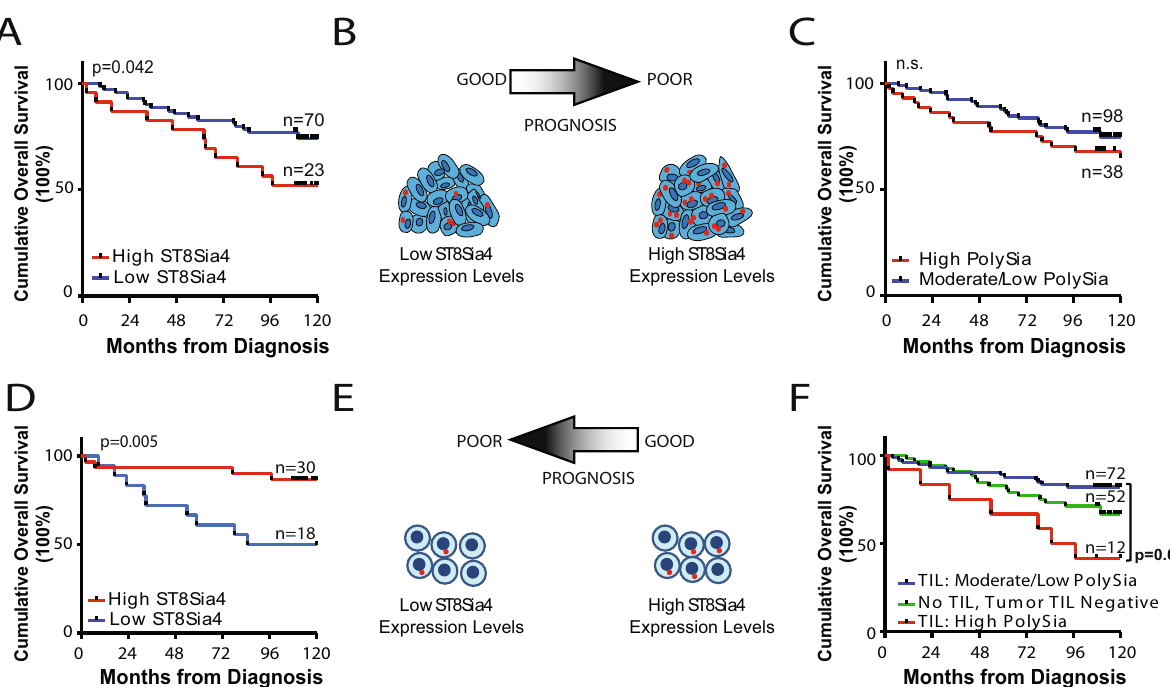
Fig. 4 Kaplan – Meier curves demonstrating survival rates relative to ST8Sia4 and polysialic acid expression in tumor cells and tumor- in fi ltrating lymphocytes. A Overall survival of individuals based on ST8Sia4 expression in tumor cells. Patients were categorized as either ST8Sia4 high (>1.25 RNA punctae/cell) or low ST8Sia4 ( ≤ 1.25 RNA puncate/cell). B Animated diagram depicting the prognostic signi fi cance of ST8Sia4 expression in tumor cells. C Overall survival of individuals based on polysialic acid levels in tumor cells. Patients were categorized as high expression ( H -Score > 0.66) or moderate/low ( H -Score ≤ 0.66). High ST8Sia4 and polySia cut-point value was set at the 75% Percentile ±SEM of all values. Overall Survival curve comparison: Log-rank (Mantel – Cox) test. D Overall survival of individuals based on in fi ltrating stromal cell ST8Sia4 expression in TIL-positive tumor cores. Patients were categorized as either ST8Sia4 high (>0.4 RNA punctae/cell) or low ST8Sia4 ( ≤ 0.4 RNA punctae/cell). High ST8Sia4 cut-point value was set at the median ± SEM of all values. E Animated diagram depicting the prognostic signi fi cance of ST8Sia4 expression in in fi ltrating stromal cells. F Overall survival of individuals based on polysialic acid levels on TIL. Patients were categorized as high expression ( H -Score > 0.55) or moderate/low ( H -Score ≤ 0.55). TIL Negative (tumor cores absent for TIL). High polySia cut-point value was set at the 75% Percentile ±SEM of all values. Overall Survival curve comparison: Log-rank (Mantel – Cox) grade and poor patient outcomes, and polySia tumor cell expression trended towards worse outcomes. We found that